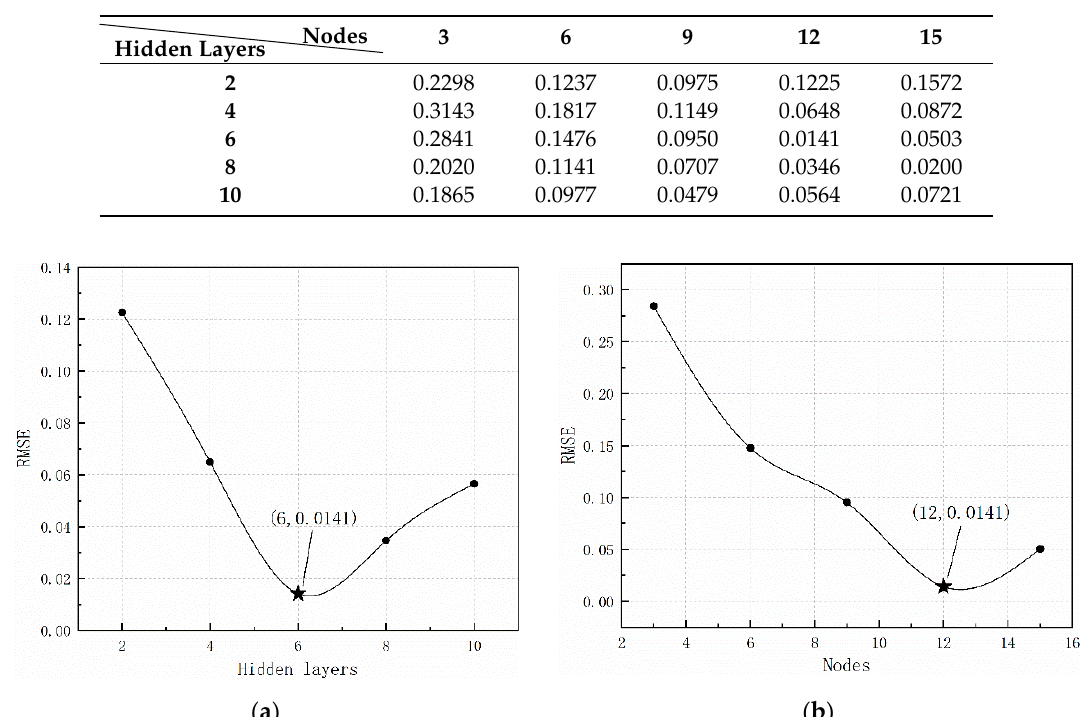
Figure 5. RMSE with different ( a ) hidden layers, and ( b ) nodes. Figure 5. Root Mean Squared Error (RMSE) with di ff erent ( a ) hidden layers, and ( b )